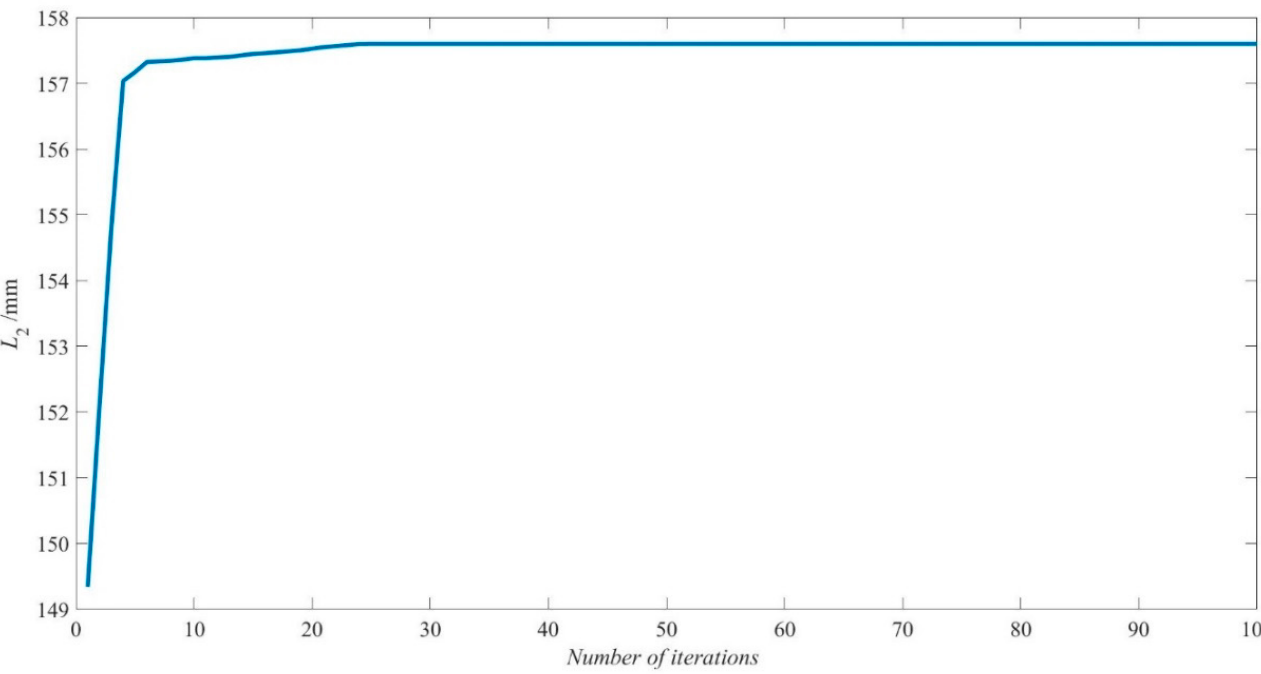
Figure 14. Convergence curve of L 2 with the number of iterations.